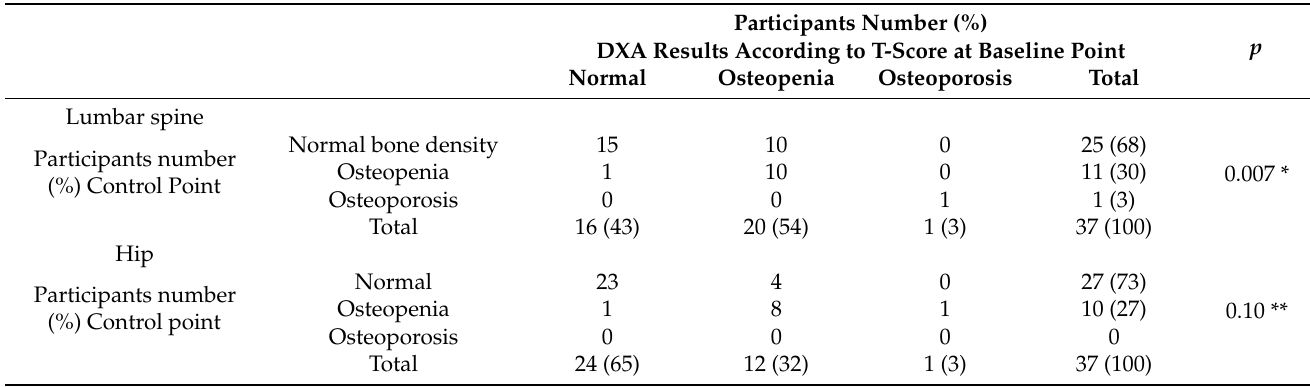
Table 5. Changes in the lumbar spine and hip bone density after one year of ATD